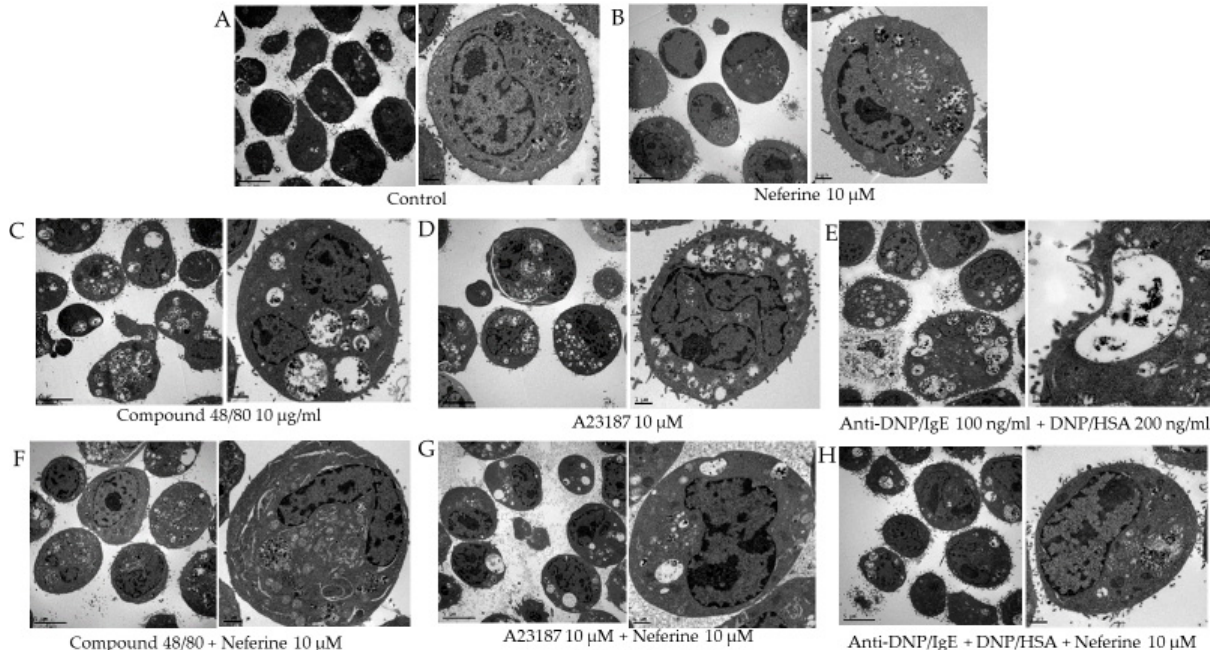
Figure 2. Degranulation of RBL-2H3 cells is induced by different activators and inhibited by neferine. ( A ) Control group. ( B ) RBL-2H3 cells are only treated with 10 µ M neferine. ( C – E ) RBL-2H3 cells are only treated with compound 48/80 10 µ g/mL for 30 min, A23187 10 μ M for 10 min, and anti-DNP/IgE (100 ng/mL) for 24 h + DNP/HSA (200 ng/mL) for 1 h. ( F – H ) RBL-2H3 cells were pretreated with neferine 10 µ M for 20 min and then various activators were added separately. The left panel is low magnification, and the right panel is high magnification.